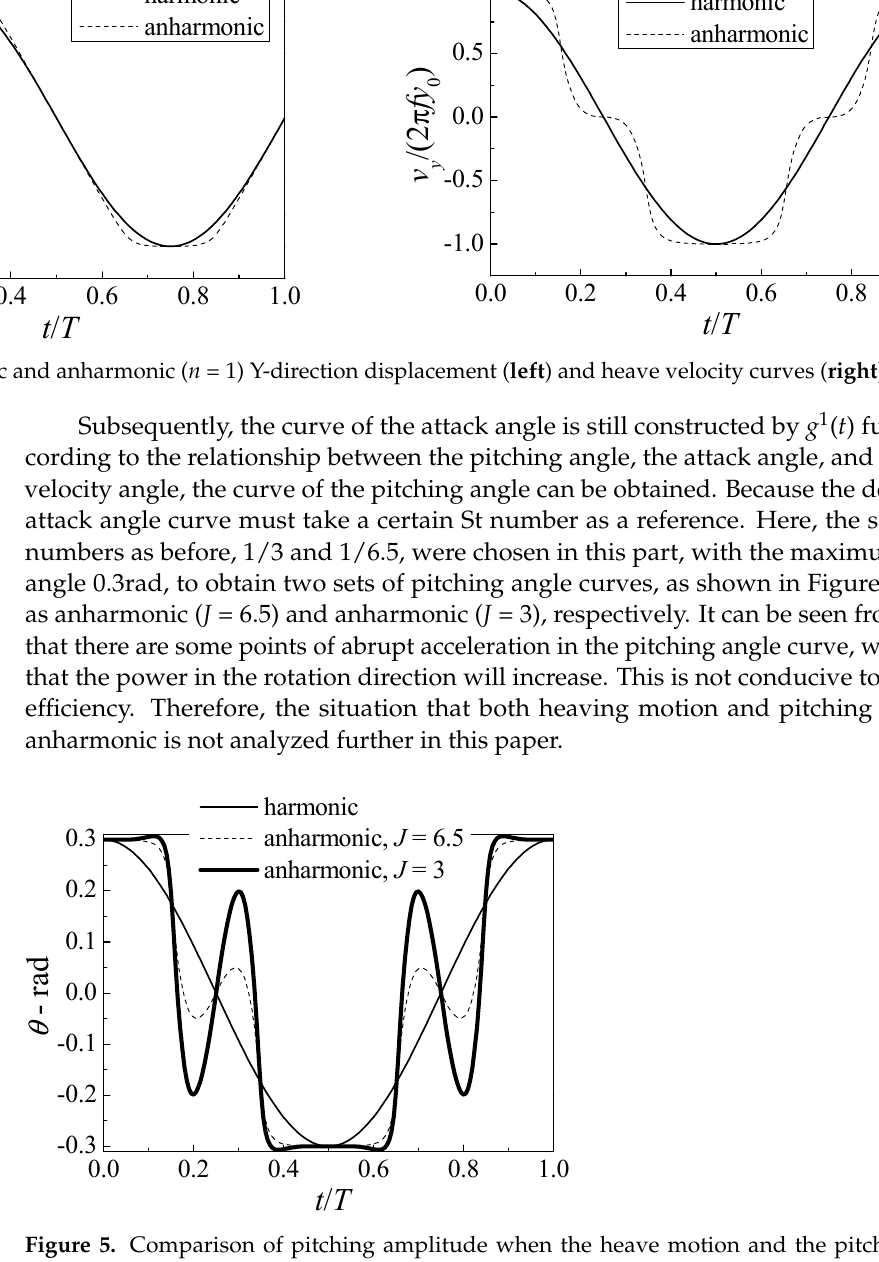
Figure 5. Comparison of pitching amplitude when the heave motion and the pitch motion are both anharmonic.